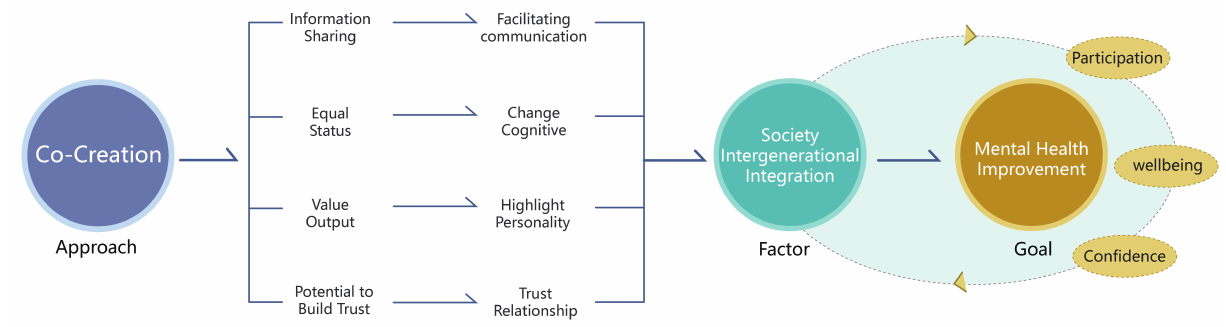
Figure 1. The Connectedness of Community Mental Health, Intergenerational Integration and Co-Creation